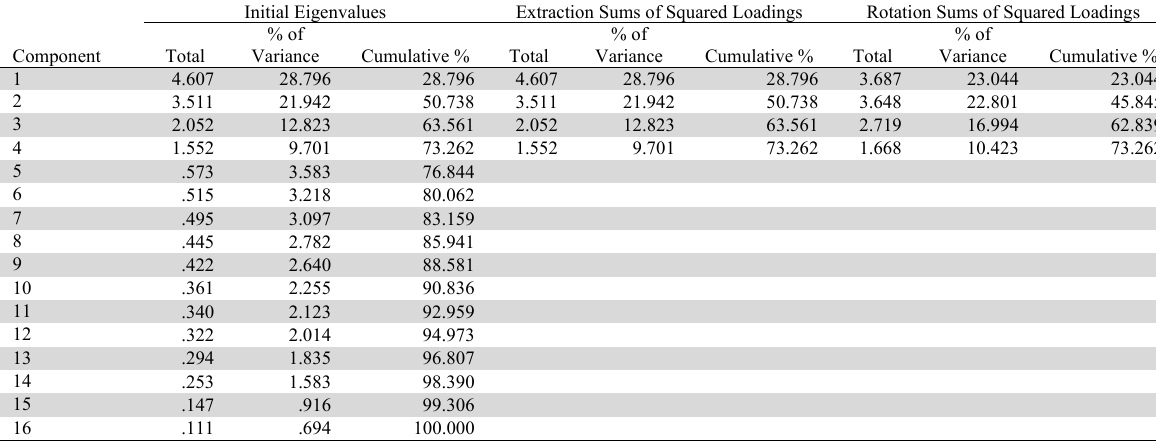
Extraction Method: Principal Component